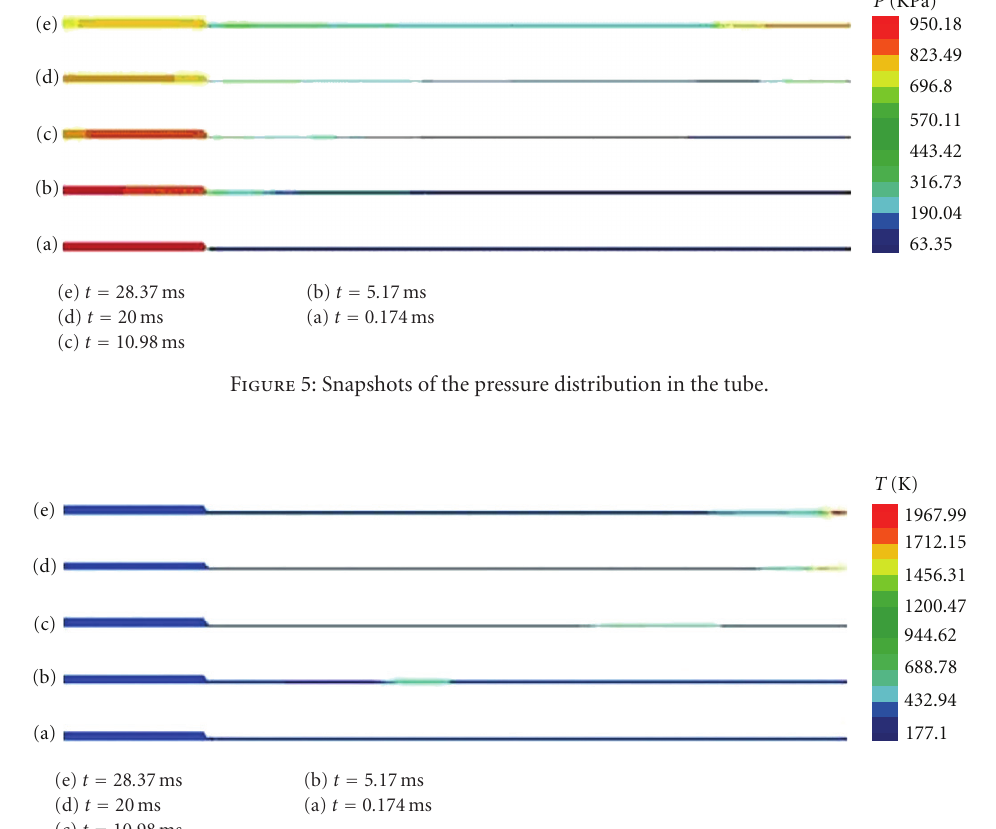
Figure 6: Snapshots of the temperature distribution in the tube.